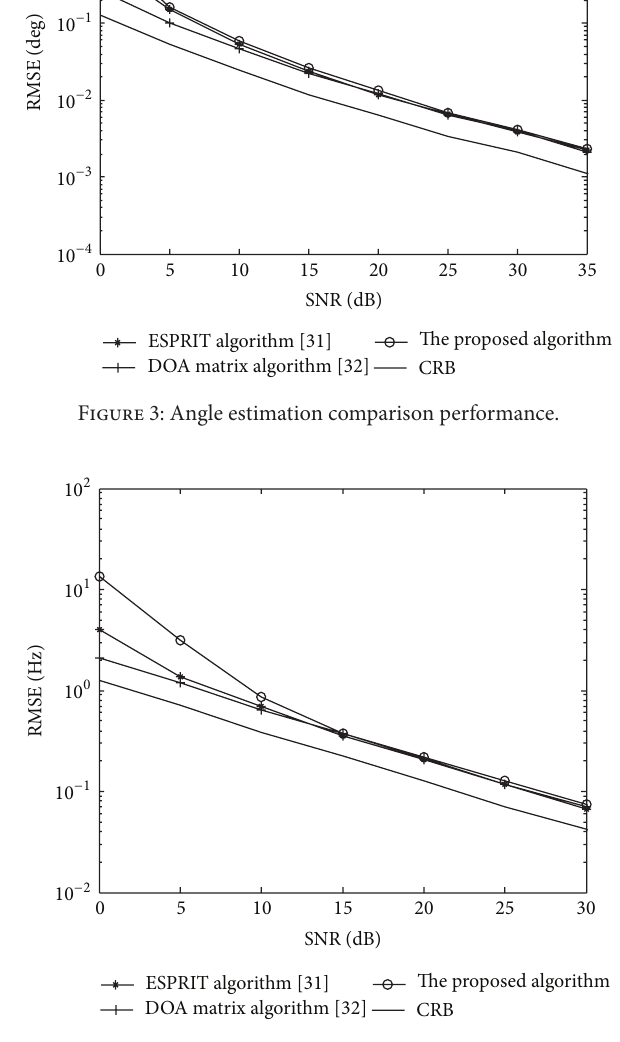
Figure 6: Doppler frequency estimation with different values of 𝐾